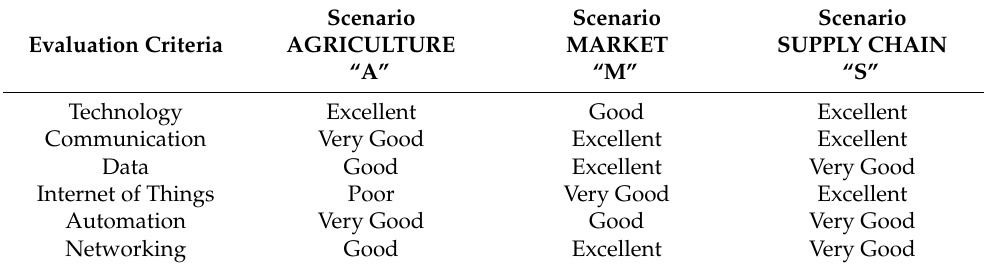
Table 2. Evaluation criteria and scenarios of digital transformation for the agrifood sector.